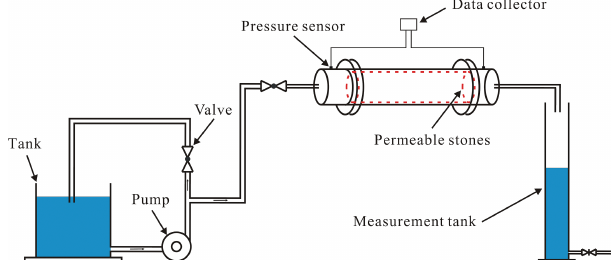
Figure 1. Schematic diagram of the experimental